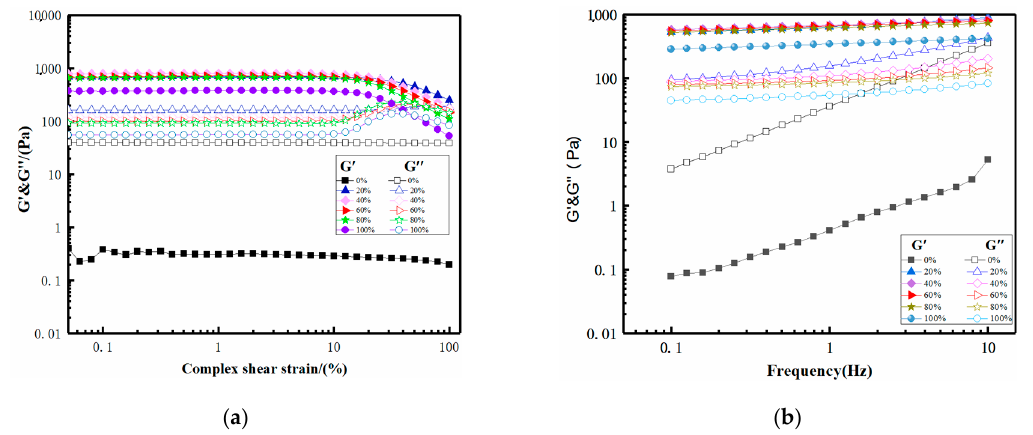
Figure 3. Detection of toxicity of xanthan gum hydrogel ( a ) and xanthan gum eutectogels with 20% water content ( b ) by MTT assay. “a” is xanthan gum hydrogel.